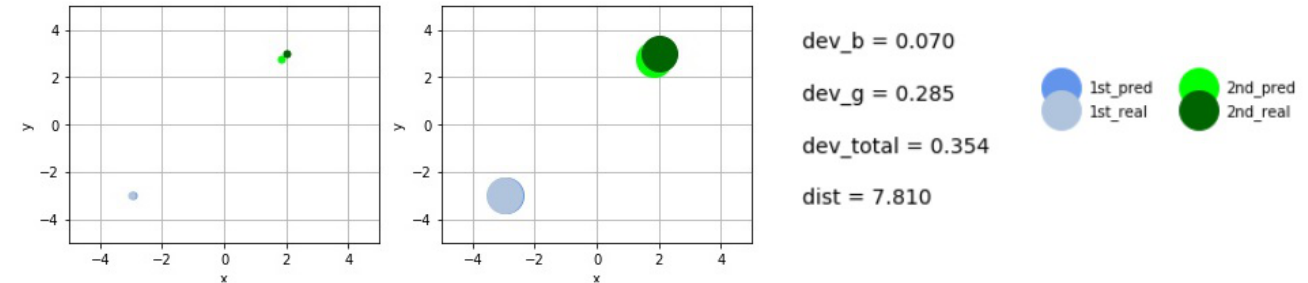
Figure 8. Example for the real and predicted midpoints and objects.